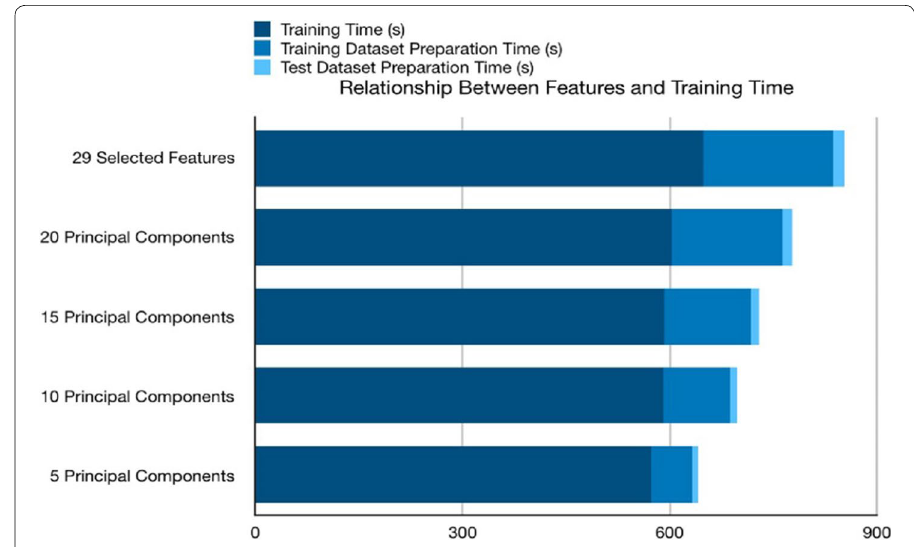
Fig. 6 Relationship between feature number and training time